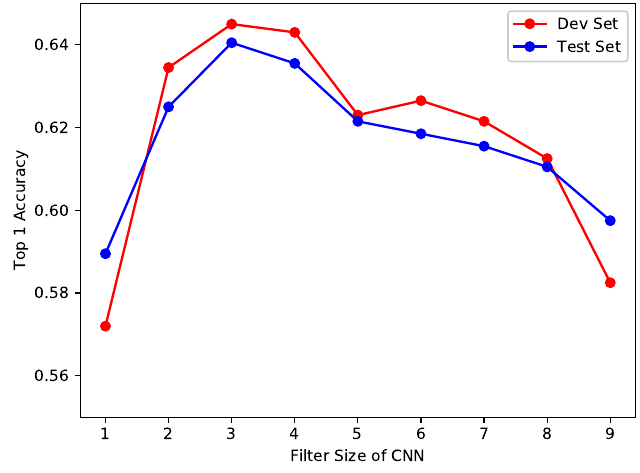
Figure 4. Top-1 Accuracy according to the filter size of